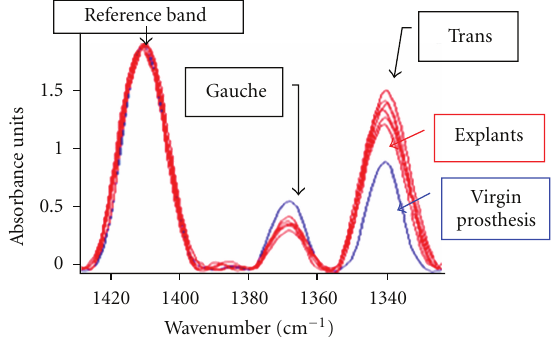
Figure 11: Change in absorbance of the 1340 (trans) and 1370 cm − 1 (gauche) bands after